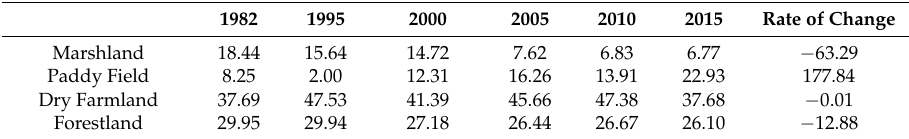
Table 2. Proportion of land use types from 1982 to 2015 (%).